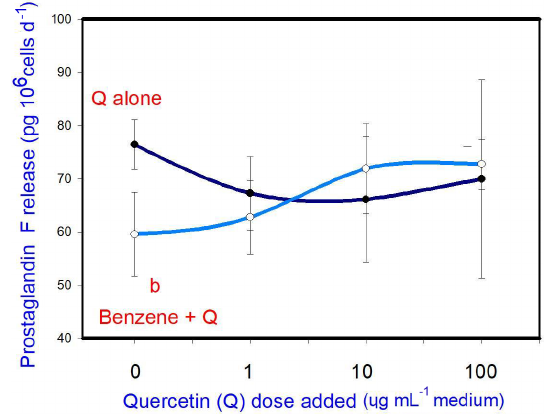
Figure 5. Effects of benzene, quercetin extract, and their combina- tion on the release of prostaglandin F in cultured porcine ovarian granulosa cells. Parts marked “a” show the effect of quercetin ex- tract (significant difference ( P< 0 . 05) between cells cultured with- out and with quercetin addition at three different levels without ben- zene), b the effect of benzene (significant difference ( P< 0 . 05) be- tween cells cultured with or without benzene for each quercetin dose separately), c the effect of quercetin extract at simultaneous benzene presence (significant difference ( P< 0 . 05) between a cell cultured with and without quercetin addition at three different lev- els with simultaneous benzene addition); effect of benzene alone (20ng · mL − 1 ) is displayed for quercetin dose at 0ng · mL −